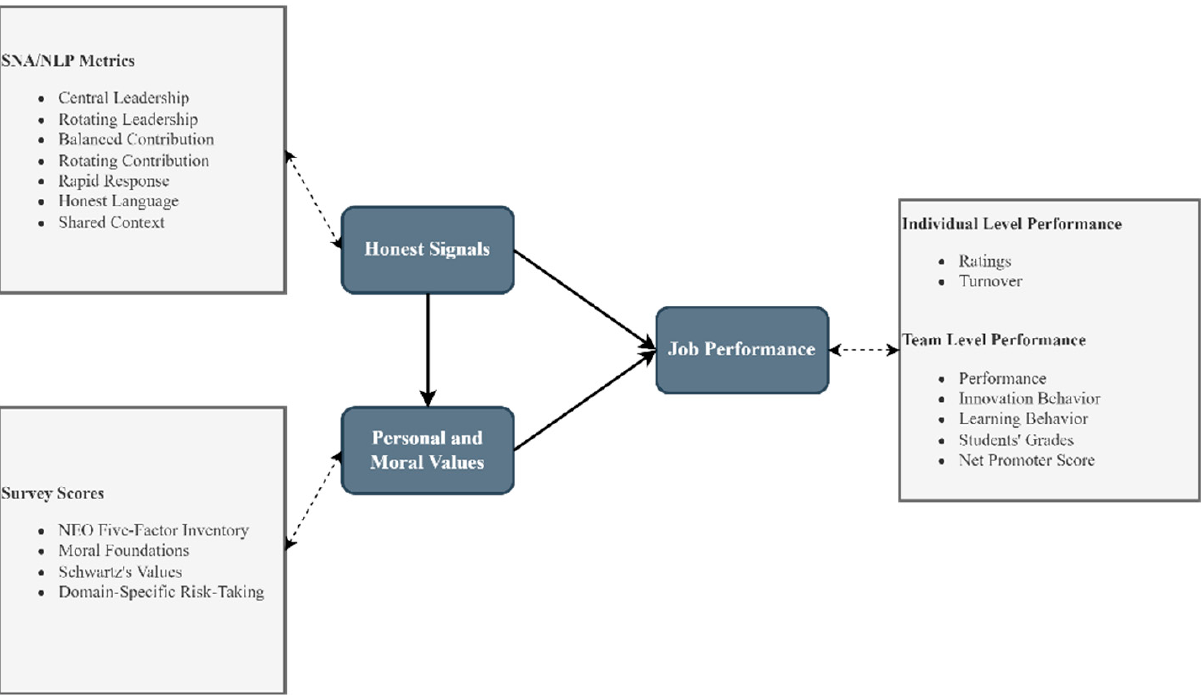
Figure 1. Theoretical Framework.